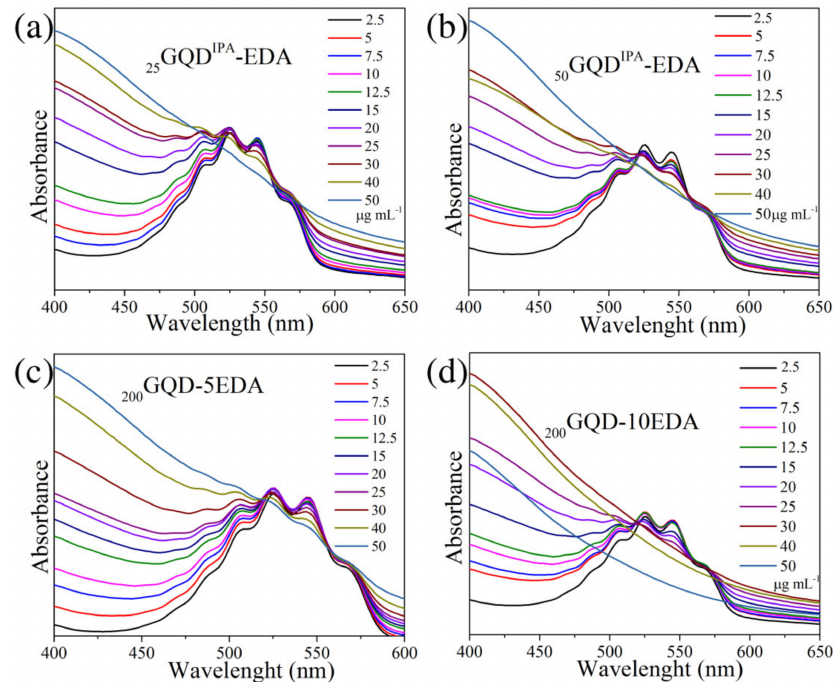
Figure 9. KMnO 4 reduction test: UV/Vis spectra of mixtures of KMnO 4 (300 mM) with GQDs samples 25 GQD IPA -EDA ( a ), 50 GQD IPA -EDA ( b ), 200 GQD-5EDA ( c ), and 200 GQD-10EDA ( d ) added in the concentrations indicated in the images, recorded after 1 h of incubation in the